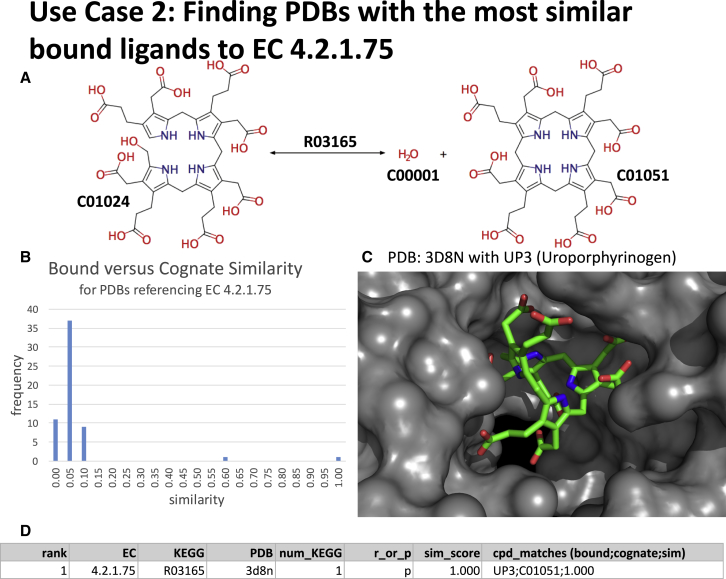
Use Case 2Graphic shows (A) the KEGG reaction for R03165 (hydroxymethylbilane hydro-lyase [cyclizing]); (B) the distribution of similarity scores between the cognate ligands and the bound ligands in PDBs referencing EC 4.2.1.75 (uroporphyrinogen III synthase); (C) a representation of the binding pocket of the best match, PDB: 3D8N (uroporphyrinogen III synthase-uroporphyrinogen III complex), with bound uroporphyrinogen; and (D) an extract from the Mendeley Data Repository for EC 4.2.1.75. (In D num_KEGG refers to the number of KEGG reactions potentially matched to the PDB via the EC in SIFTS, r_or_p refers to whether reactants [r] or products [p] have been matched, and cpd_matches details the bound and cognate matched ligands in the format bound; cognate; similarity_score with multiple matches separated by an underscore.)